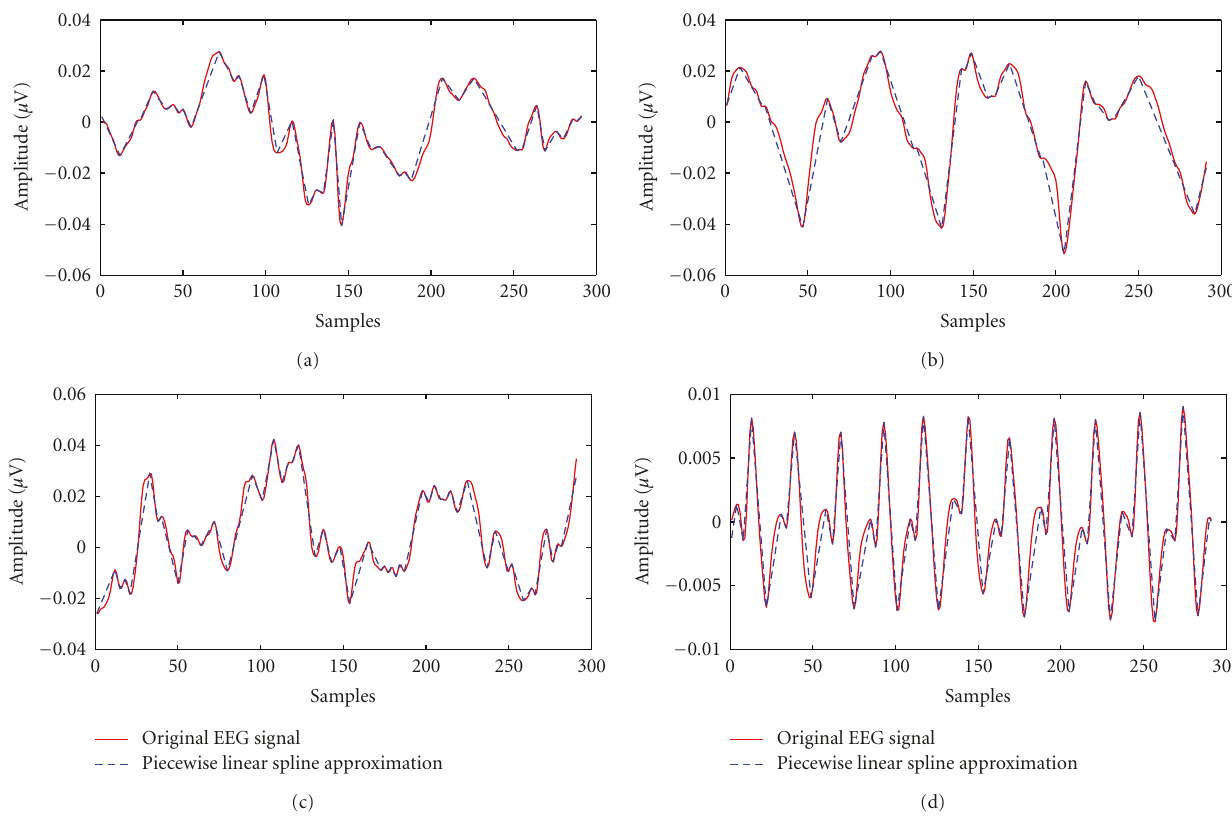
Figure 2: Examples of modelling di ff erent EEG signals with K -pieces nonuniform linear splines. (a) K = 37 pieces. (b) K = 23 pieces. (c) K = 53 pieces. (d) K = 45 pieces. Table 1: Comparison of di ff erent approximation models for 30 epochs of EEG